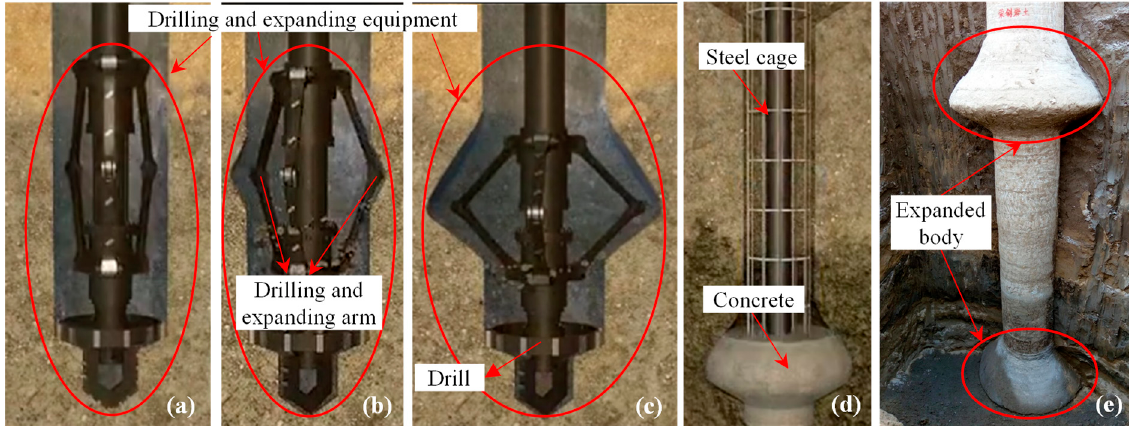
Figure 1. The process of creating a drill-expanded concrete pile and a photo of a real pile: ( a ) drilling the hole; ( b ) expanding the hole; ( c ) expanding completed; ( d ) pouring concrete; ( e ) photo of a real drill-expanded concrete pile.